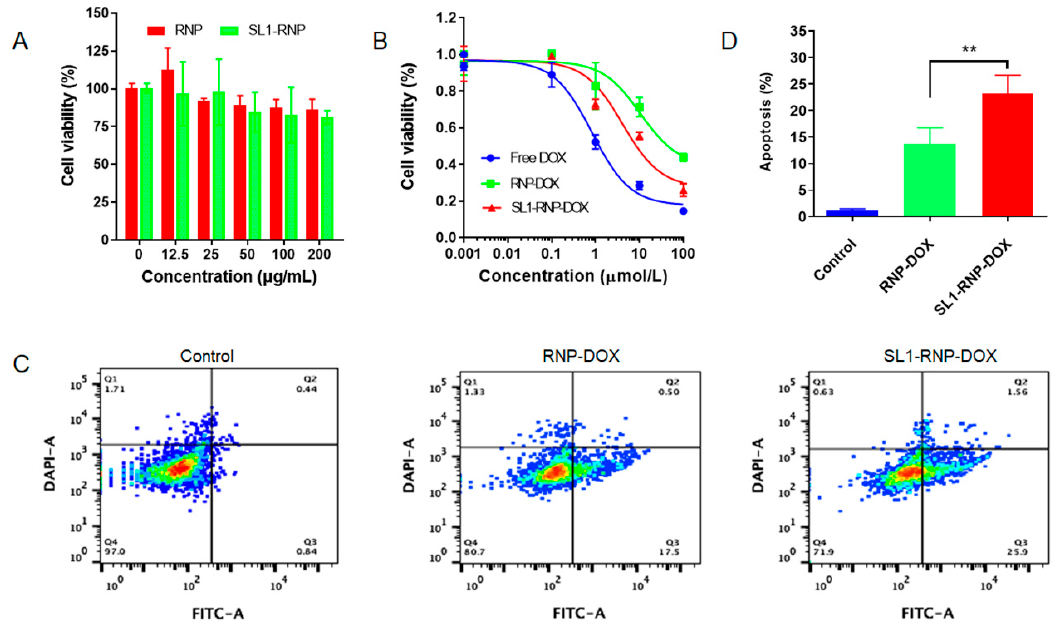
Figure 2. In vitro anti-GBM activity of SL1 − RNP − DOX. ( A ) Cell viability of U87MG cells treated with different nanoparticles of various concentrations ( n = 4). ( B ) Cell viability of U87MG cells treated with free DOX, RNP − DOX, and SL1 − RNP − DOX ( n = 4). ( C ) Representative flow cytometry histograms of U87MG cells treated with RNP − DOX and SL1 − RNP − DOX and ( D ) the corresponding total apoptosis of cells ( n = 3). ** p < 0.01.